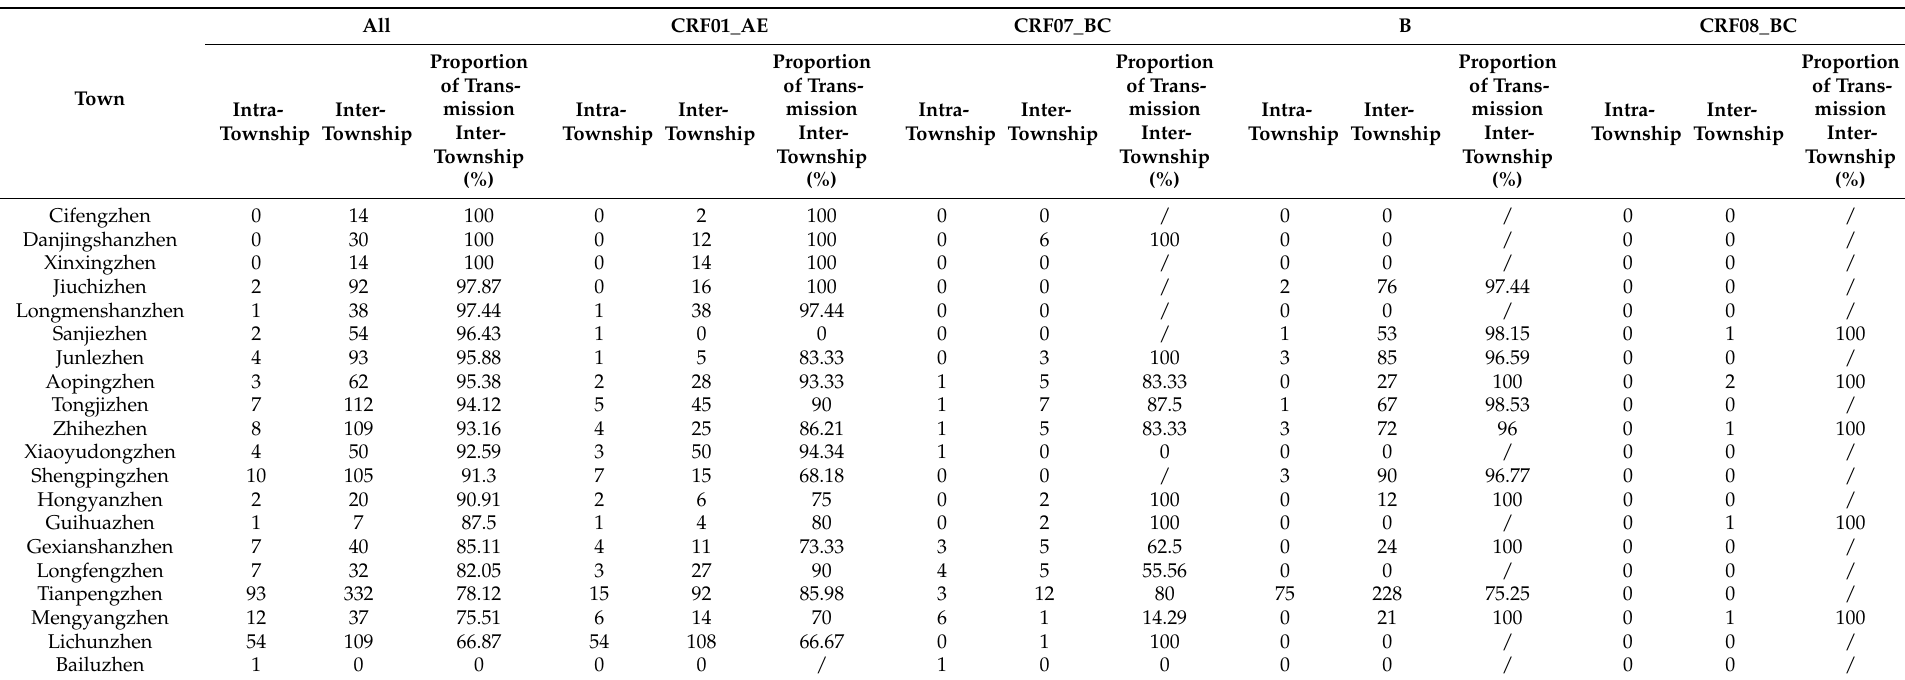
Table 2. Analysis of the results of inter-township and intra-township connections of newly reported HIV infections among towns in Pengzhou.